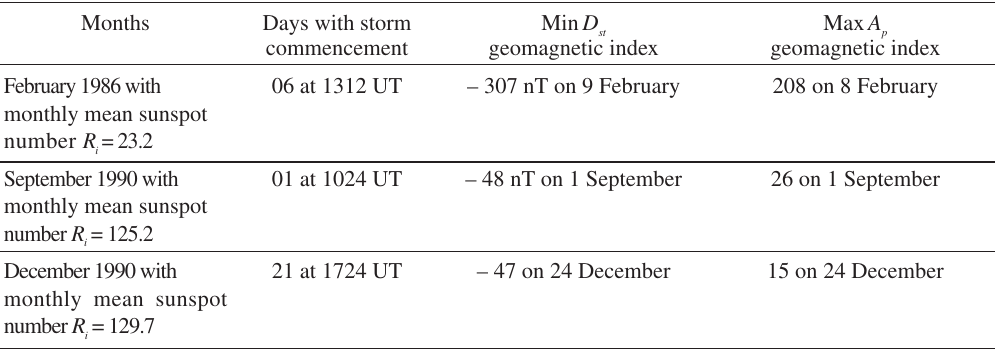
Table II. Solar-terrestrial conditions during selected periods used in this Months